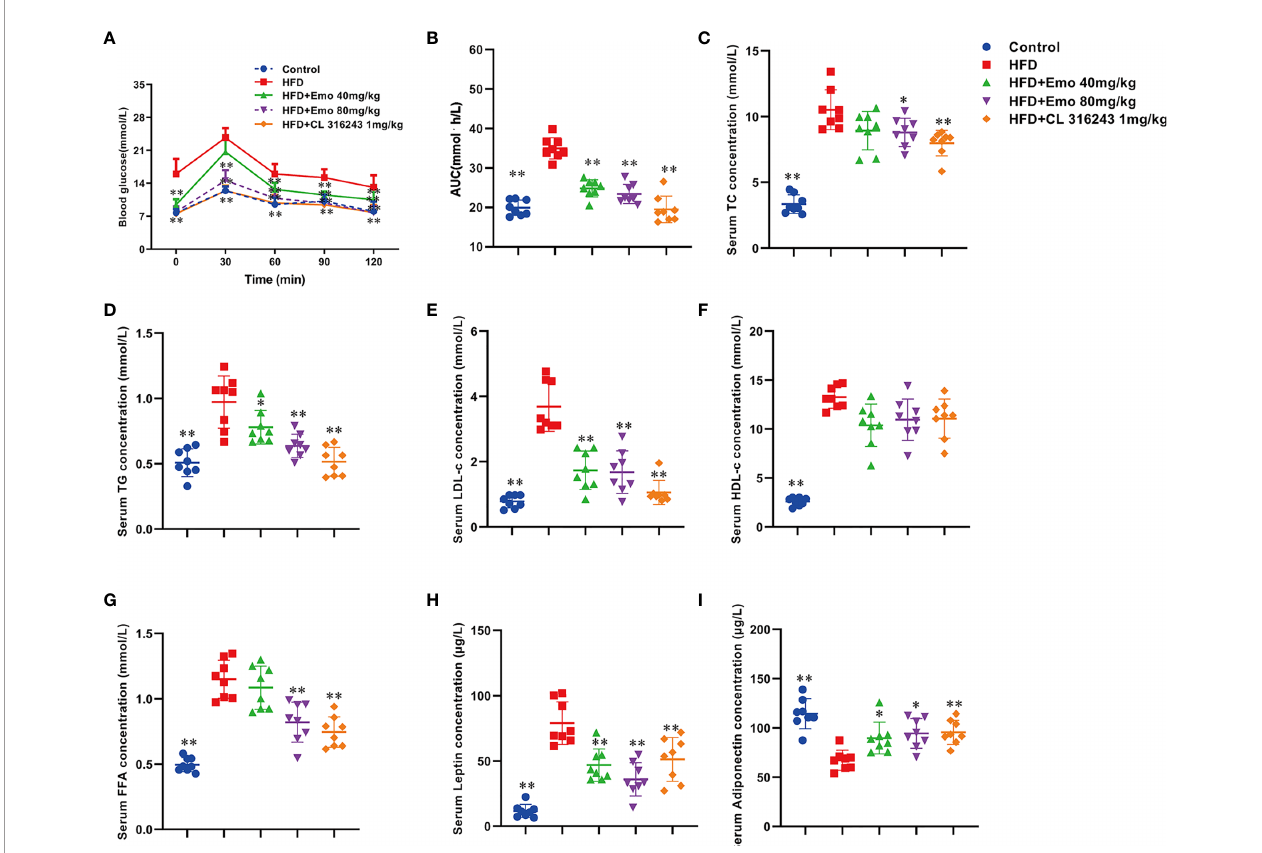
FIGURE 2 | Effects of emodin on blood glucose and lipids in HFD mice. (A) Oral glucose tolerance test (OGTT). The mice were fasted for 12 h, and then 2 g/kg glucose was given oral gavage. Glucose levels were tested before (0) and after fed glucose at 30, 60, 90, and 120 min. (B) Quanti fi cation of AUC from the OGTT. (C – F) Serum TC, TG, LDL-c, HDL-c concentration. (G) Serum free fatty acids concentration. (H) Serum leptin concentration. (I) Serum adiponectin concentration. HFD, high fat diet; Emo, emodin. Data are expressed as mean ± SE, with n = 8. * P < 0.05, ** P < 0.01 vs. HFD